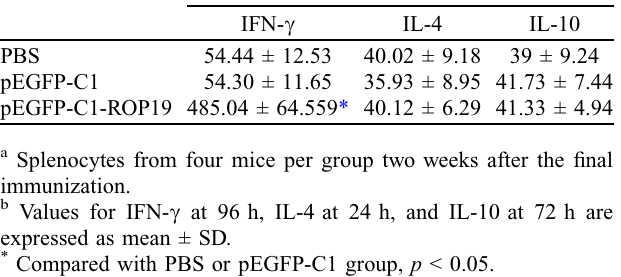
Table 3. Cytokine production by splenocyte a cultures from immu- nized BALB/c mice.